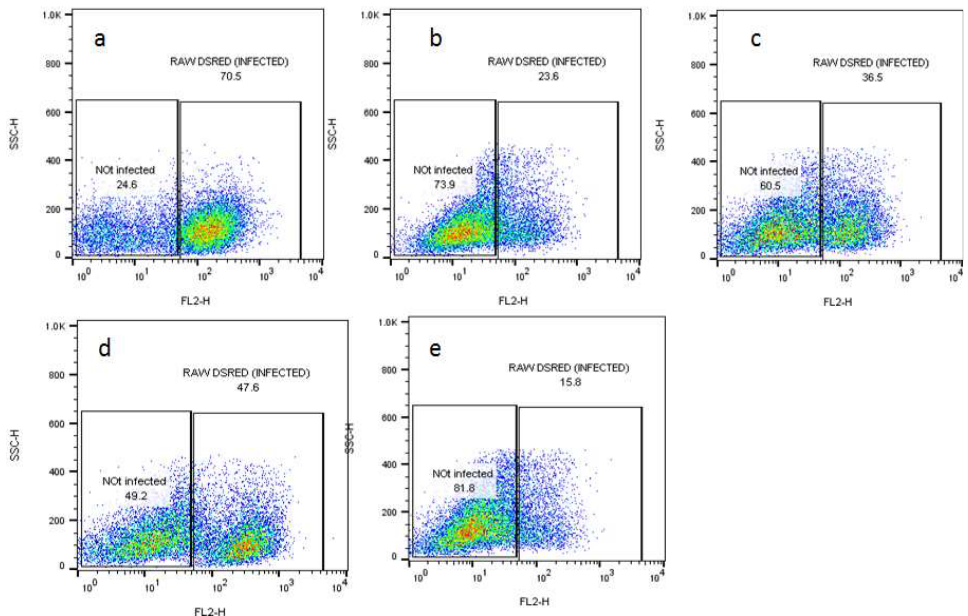
Figure 4. BMDMs infected with transgenic L. donovani parasites expressing the red fluorescent protein Ds-Red for the evaluation of parasitic loads using flow cytometry. Treatment was conducted with ( a ) untreated control and cells treated with ( b ) quercetin, ( c ) gallic acid, and ( d ) rutin at their inhibitory concentrations (IC 50 ) (84.65 µg/mL, 86 µg/mL, and 98 µg/mL, respectively) for 72 h. ( e ) SSG 250 µg/mL was used as a positive control.